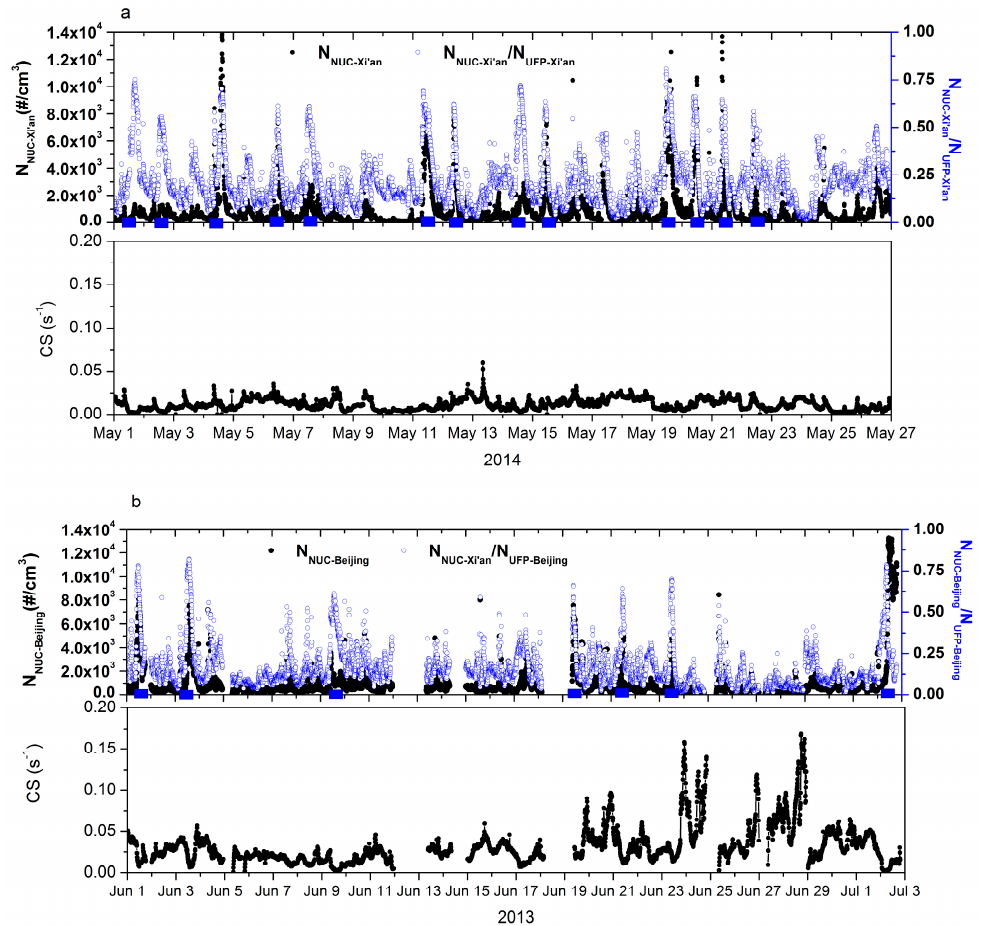
Figure 3. Temporal evolution of N NUC , its ratio to N UFP and the corresponding CS at the suburban site of Xi’an ( a ) and at the suburban site of Beijing ( b ). Blue filled rectangles represent new particle formation (NPF) events.